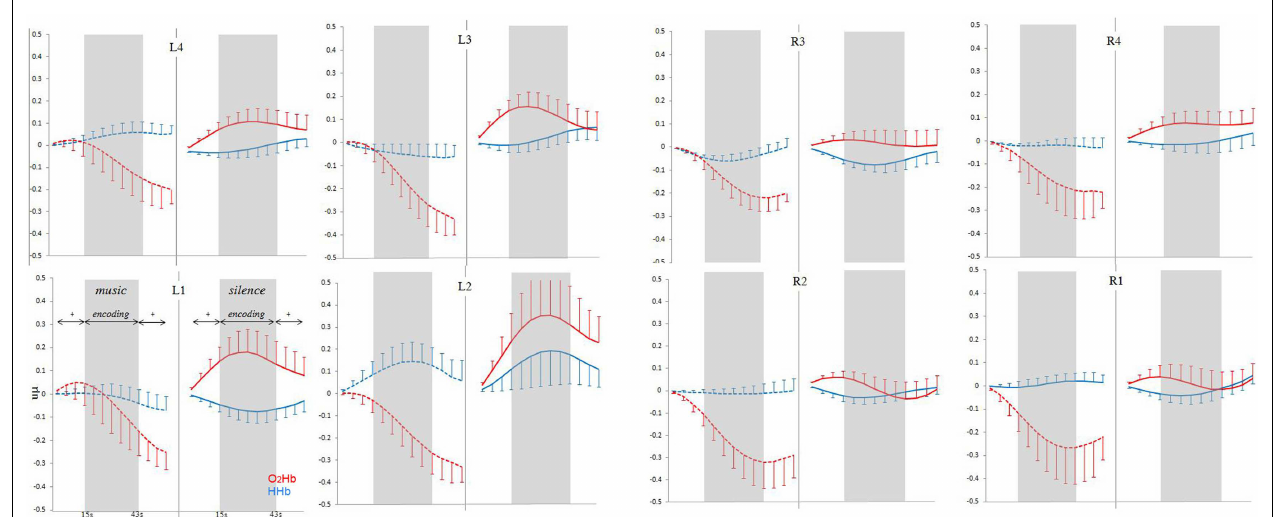
FIGURE 4 | Grand-average ( ± SEM) time-course of prefrontal cortex O 2 Hb (red lines) and HHb (blue lines) concentration changes (vertical axis) over the left and right hemisphere during memory encoding (horizontal axis: time) for the silence (right side, solid lines) and music (left side, dashed lines) conditions